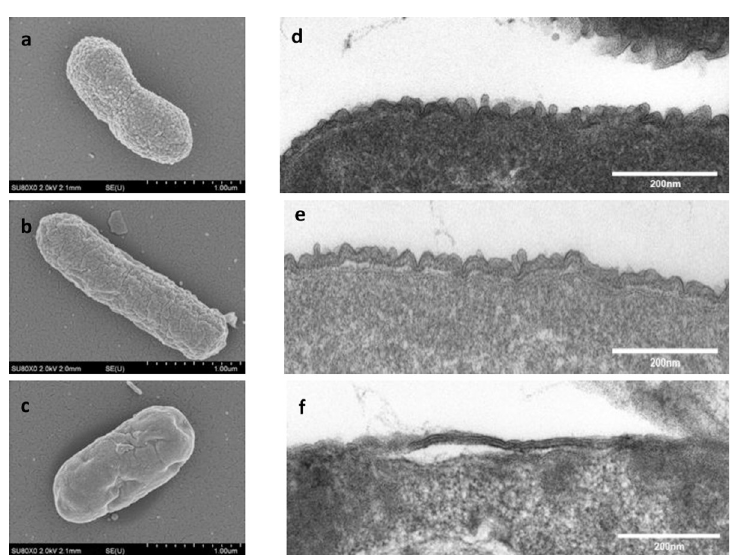
Fig 3. Membrane morphology of EBST is similar to live ST. Scanning electron microscopic analysis shows presence of intact bacterial cell membrane for (A) Live ST and (B) EBST. (C) HKST appears to be morphologically uneven with shrunken cell membrane. Transmission electron micrographs of (D) live ST (E) EBST and (F) HKST reveals the presence of surface molecules on bacterial cell membrane of both live and EBST. HKST shows a smoothened surface indicative of loss of surface